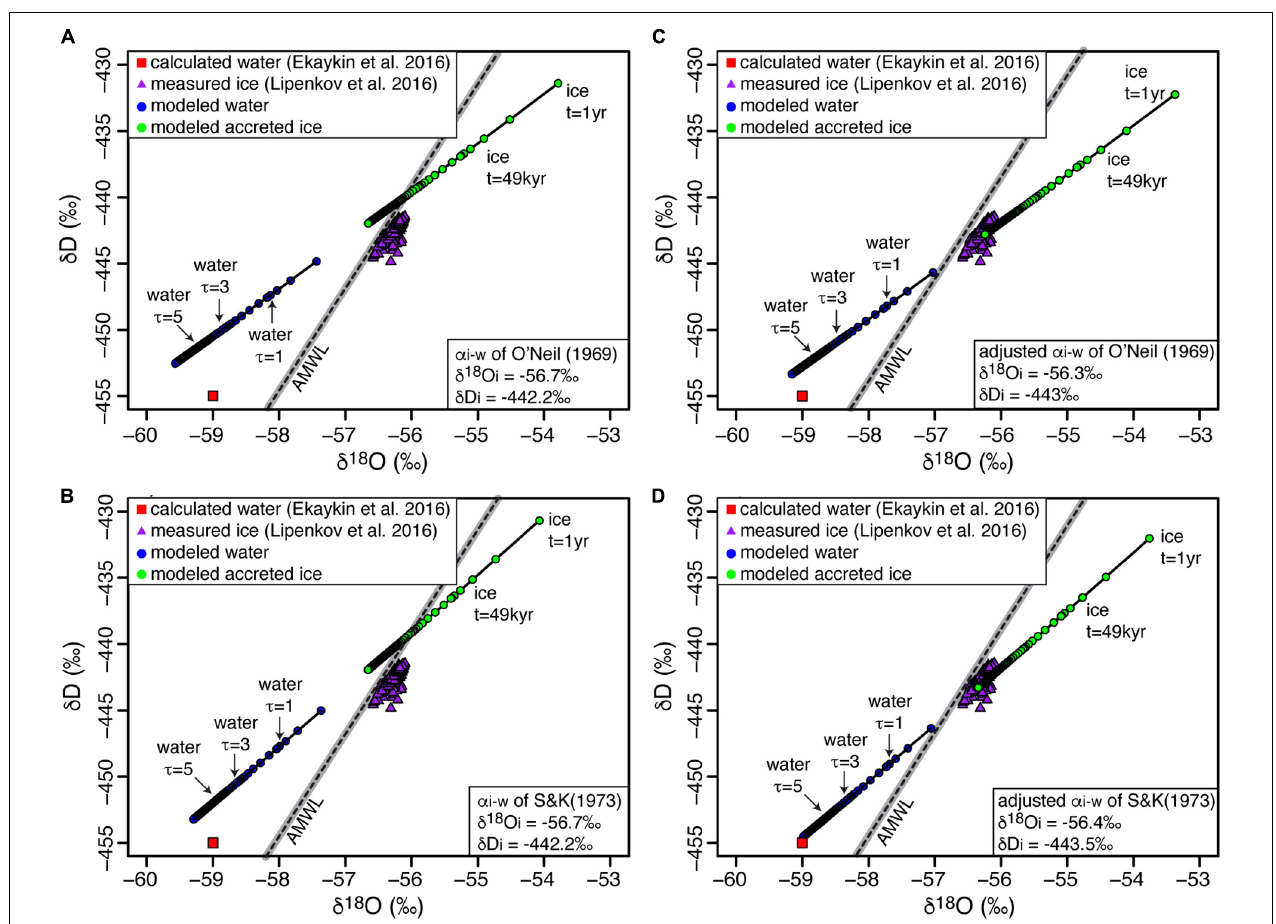
FIGURE 4 | Modeled δ D- δ 18 O composition of Lake Vostok’s upper water column and accreted ice using the initial δ D- δ 18 O input values of Royston-Bishop et al. (2004) with (A) O’Neil’s (1968) and (B) Suzuoki and Kimura’s (1973) fractionation factors. Modeled δ D- δ 18 O composition of Lake Vostok’s upper water column and accreted ice but adjusting δ D- δ 18 O inputs to fit measured accreted lake values by Lipenkov et al. (2016) using (C) O’Neil’s (1968) and (D) Suzuoki and Kimura’s (1973) fractionation factors, respectively. AMWL, Antarctic Meteoric Water Line ( δ D = 7.75 δ 18 O – 4.93; r 2 = 0.99); gray bar represents 99% confidence interval. See Table 1 for values of input parameters used in